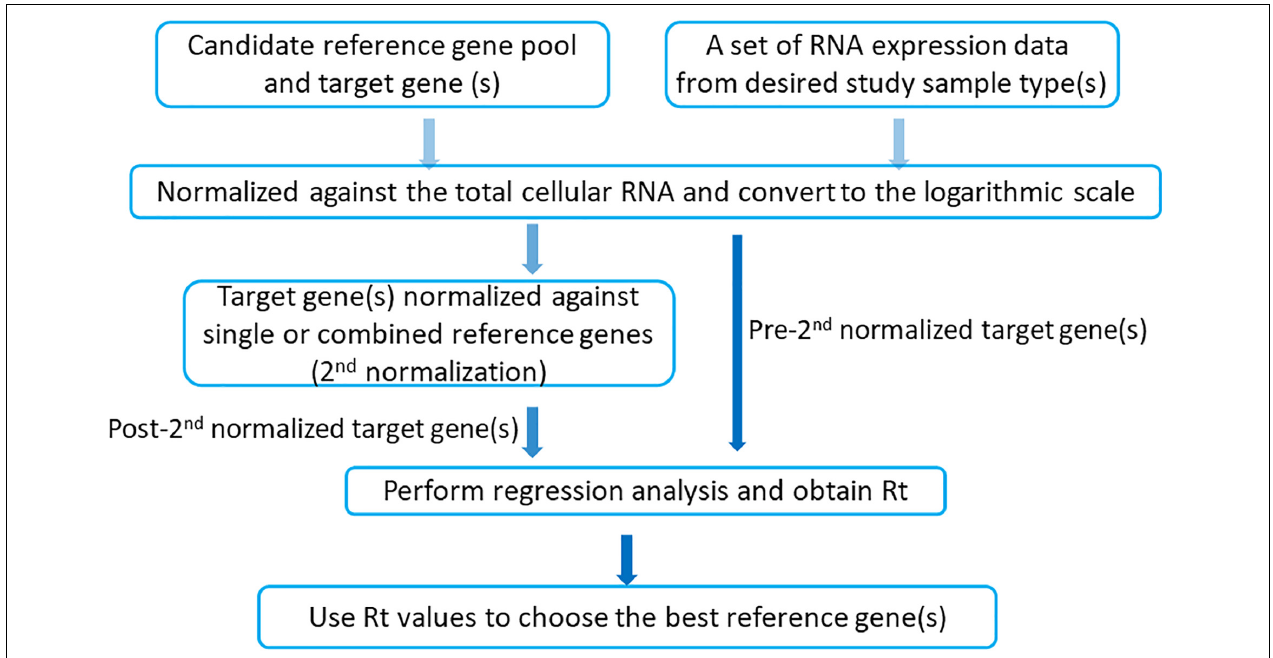
FIGURE 1 | iRGvalid